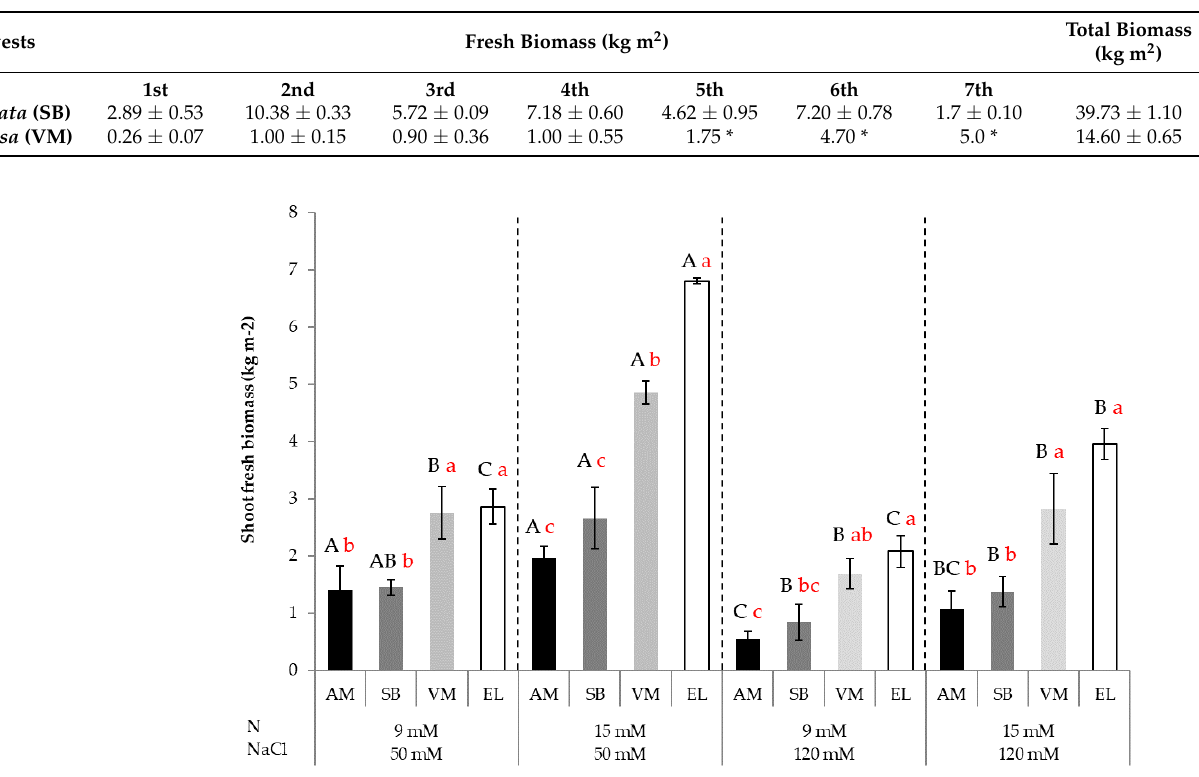
Table 2. Fresh shoot biomass in Salicornia brachiata (SB) and Sarcocornia fruticosa (VM) for seven har- vests approximately 40 days apart over one year. Plants were grown under greenhouse conditions and with natural daylight and 9 mM N and 50 mM NaCl. The means plus standard errors (±SE) of each harvest are shown, n = 2, * n = 1.